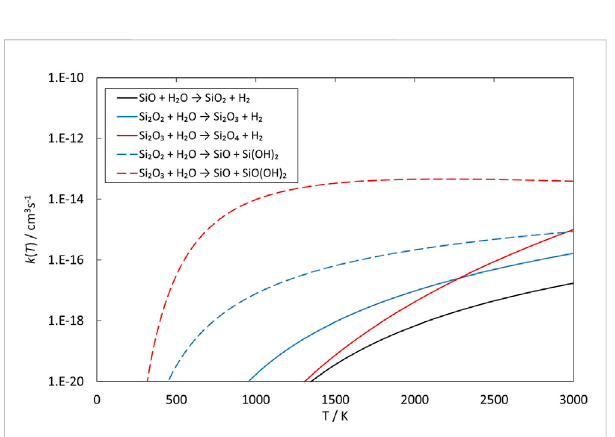
FIGURE 6 Rate coef fi cients ( fi t to RRKM calculations) of reactions involving SiO, Si 2 O 2 and Si 2 O 3 reacting with H 2 O as a function of temperature.